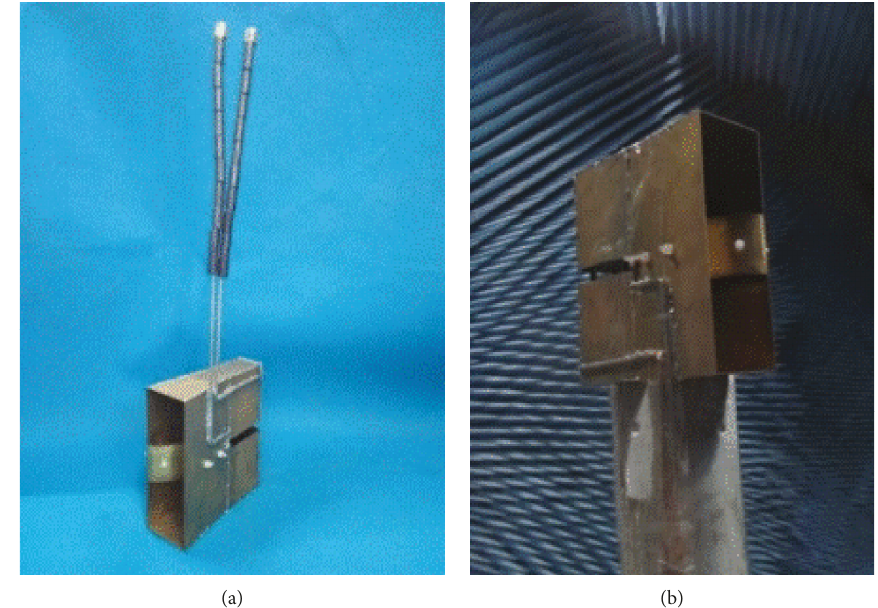
Figure 11: An archetype of the wideband DP quasi-omnidirectional antenna: (a) an archetype and (b) measurement setup.